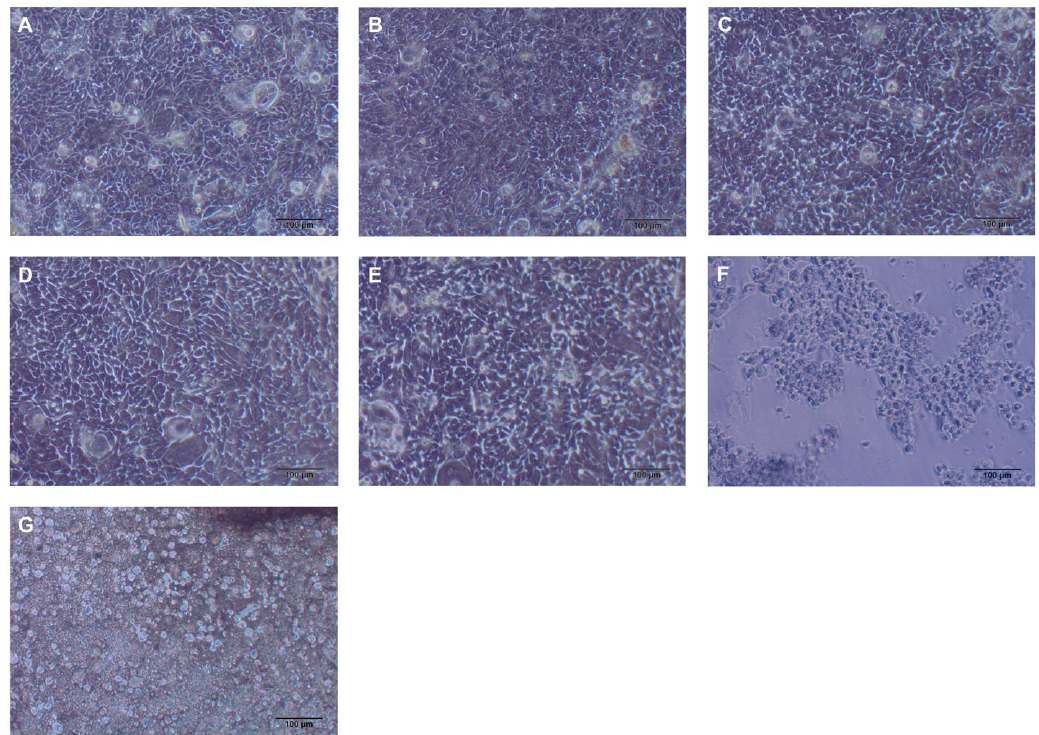
Figure 6. Day 1 samples of GE-1 cells incubated with materials under magnification 10×. ( A ) Control, ( B ) cotton, ( C ) PTFE, ( D ) paraffin, ( E ) wax, ( F ) gutta percha, and ( G ) caviton ex.